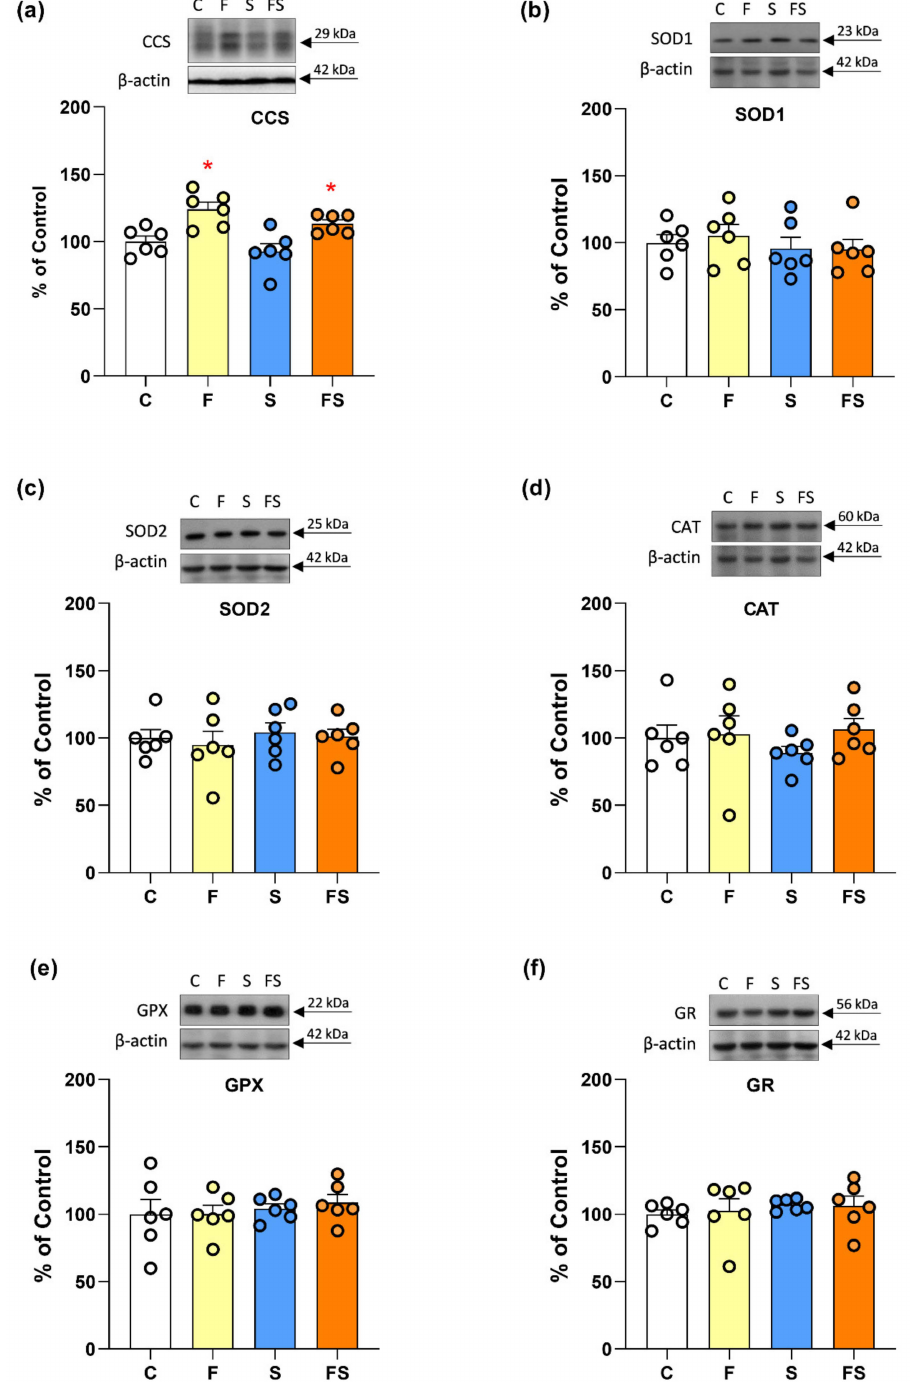
Figure 3. Effects of liquid fructose supplementation and/or stress on the level of copper chaperone CCS and antioxidant enzymes. Groups: control (C), fructose-fed (F), stress (S) and fructose + stress (FS). Protein level of CCS ( a ), SOD1 ( b ) and SOD2 ( c ), CAT ( d ), GPX ( e ) and GR ( f ) in renal whole cell extracts, was measured by Western blot. Scatter plot with bar graphs represent the means ± SEMs for each protein normalized to β -actin and expressed relative to controls ( n = 6 animals/group). Two-way ANOVA was used to evaluate the effects of fructose and stress, and their interaction. Asterisk denotes statistically significant main effect of fructose. p <